Question: What visual encoding does this figure use to show its data?
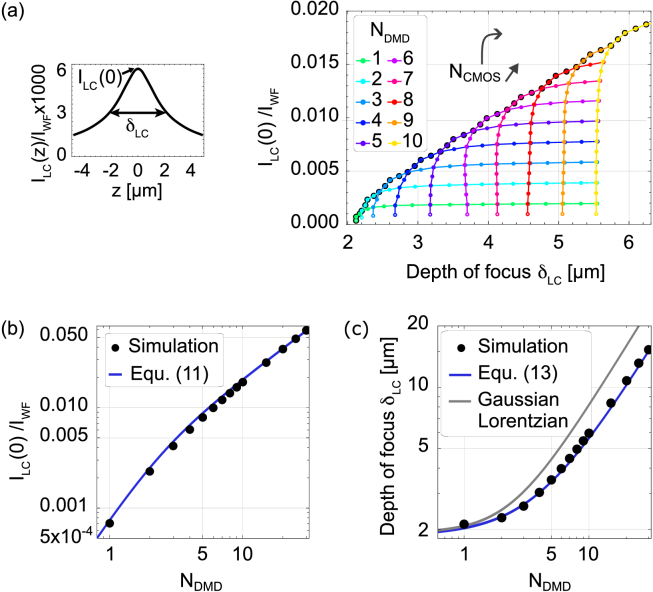
Answer: line